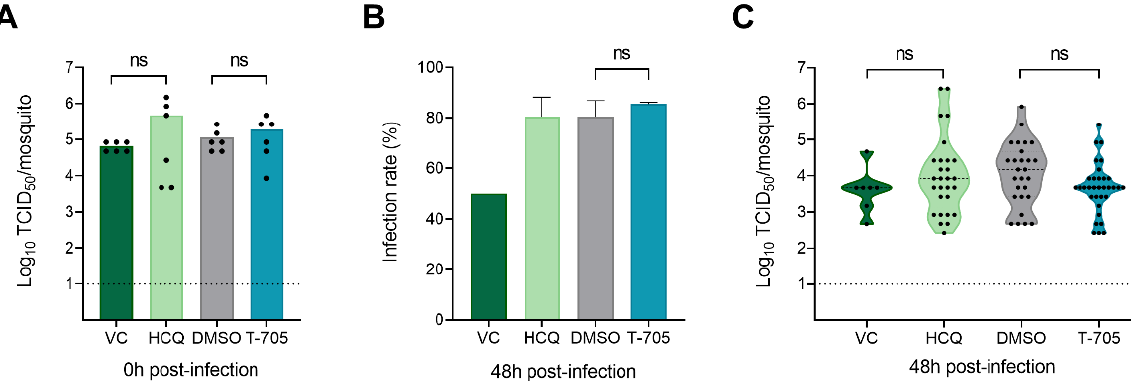
Figure 2. T-705 does not inhibit CHIKV in Aedes aegypti Paea mosquitoes. Ae. aegypti mosquitoes were fed with a blood meal containing CHIKV, CHIKV, and DMSO (0.8%), T-705 in DMSO (600 µ M) or hydroxychloroquine in sterile water (HCQ, 200 µ M). Engorged females were collected at 0 h post-infection and kept until 48 h post-infection. ( A ) Infectious virus titers in whole mosquitoes at 0 h post-infection, determined by end-point dilutions on Vero cells. ( B ) The infection rate represents the proportion of infected mosquitoes at 48 h post-infection among all engorged females tested (VC, n = 16; DMSO, n = 34; T-705, n = 41; HCQ, n = 34). ( C ) Infectious virus titers in whole mosquitoes at 48 h post-infection, determined by end-point dilutions on Vero cells. The data shown are the result of two independent experiments (for DMSO, T-705, HCQ). The VC data are the result of one experiment. The bars show the mean value ( ± SD) per condition. The dashed line ( A , C ) represents the limit of detection. The dotted lines in the violin plots ( C ) represent the median value per condition. Statistically significant differences between two groups were analyzed with the Mann-Whitney test (ns = p >